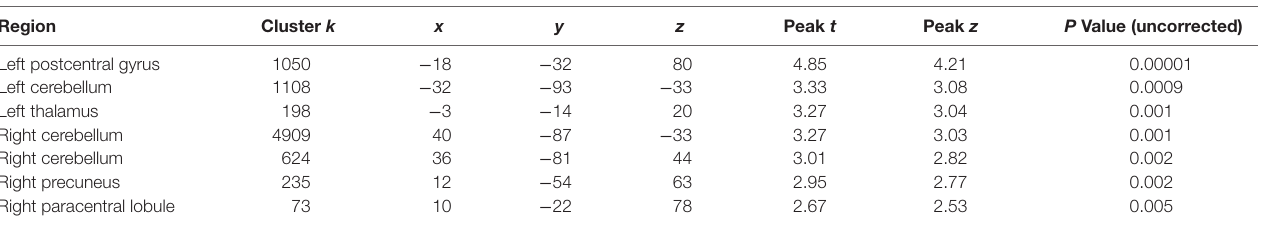
TABLE 3 | Regions of significant (local maxima) reduced gray matter (GM) volume in AOs compared with NOs. Region Cluster k